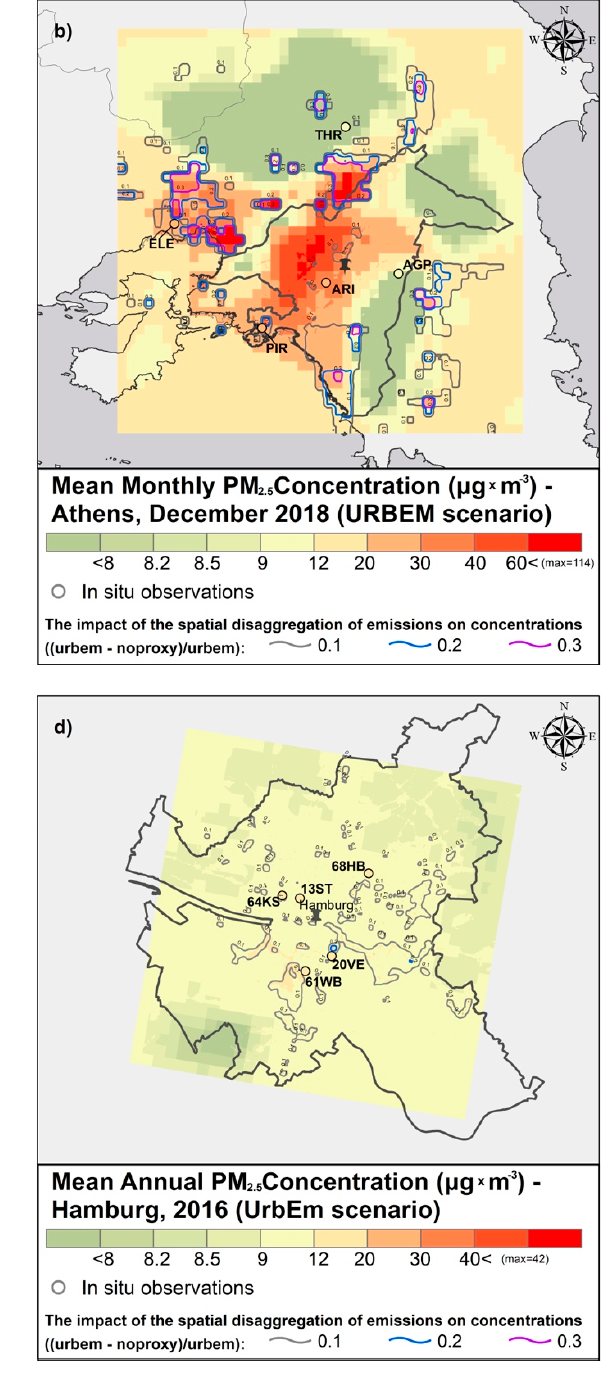
Figure 9. Map plots of CTM AQ ( μ g m − 3 ) results for ( a ) NO 2 , ( b ) PM 2.5 in Athens, and ( c ) NO 2 , ( d ) PM 2.5 in Hamburg. The difference (0–1) of concentrations between the scenarios is shown in isopleths. The colored circles are the measured values.